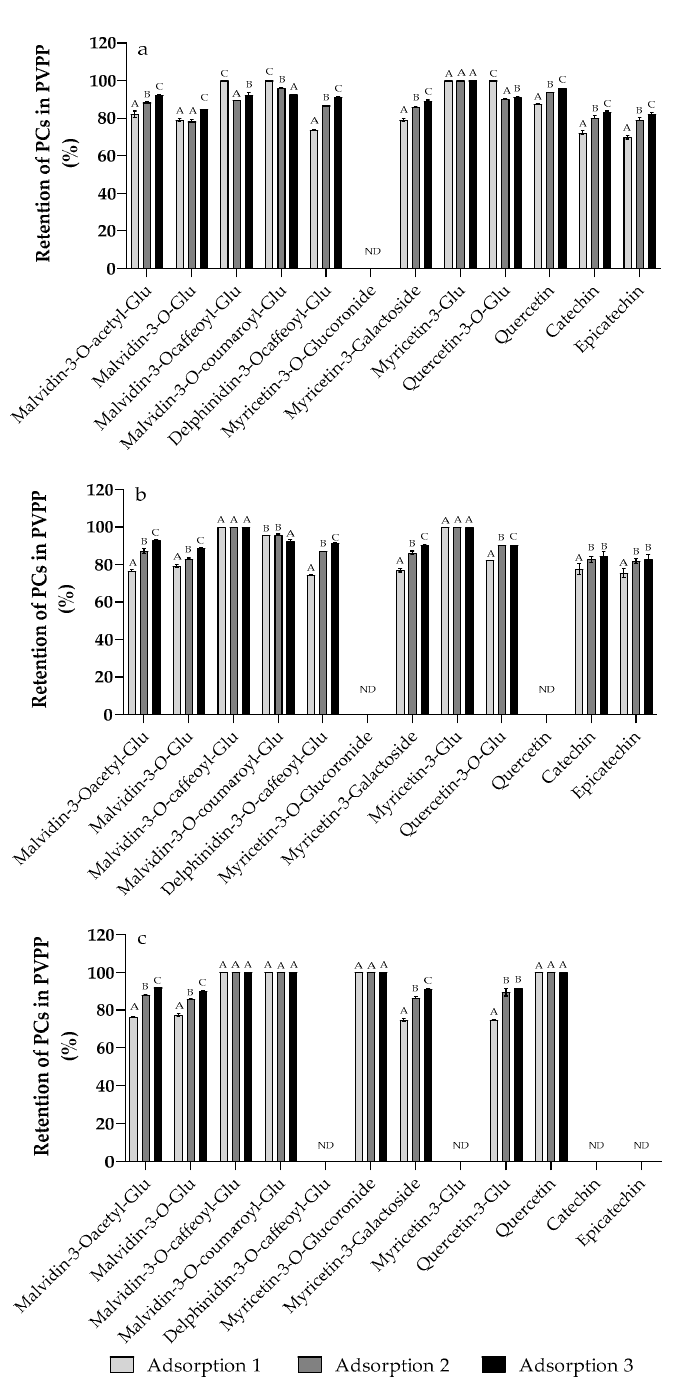
Figure 3. Percentage of PC adsorbed on PVPP for each quantified compound from Carménère ( a ), Merlot ( b ), and Cabernet Sauvignon ( c ) GPs extracts. Adsorptions 1, 2, and 3 correspond to consecutive adsorption processes from 1 to 4, 5 to 8, and 9 to 12, respectively. Different capital letters indicate significant differences ( p > 0.05) in the TPC or antioxidant capacity between masses or agitation at the same time. ND: Not detected (<LOD).